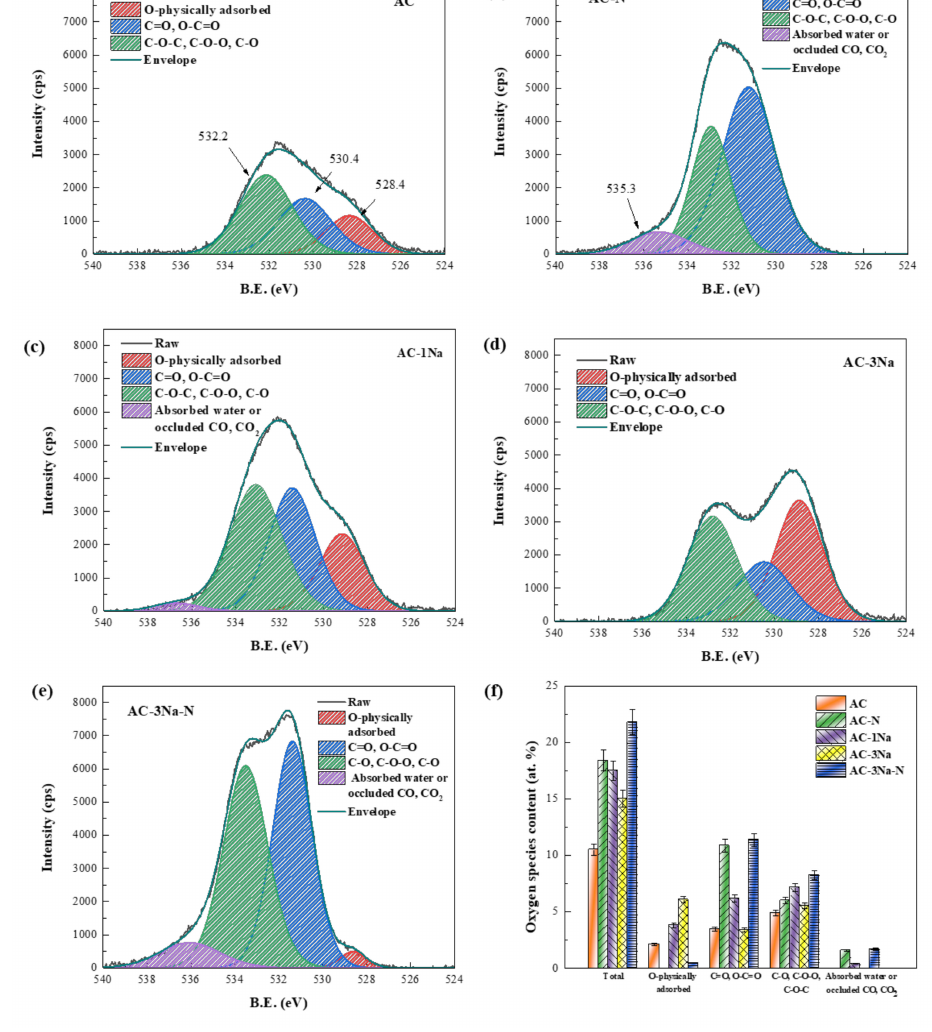
Figure 2. Deconvolution of the XPS O1s spectra of the AC catalysts: ( a ) AC, ( b ) AC-N, ( c ) AC-1Na, ( d ) AC-3Na, ( e ) AC-3Na-N, and ( f ) oxygen species content (B.E. = binding